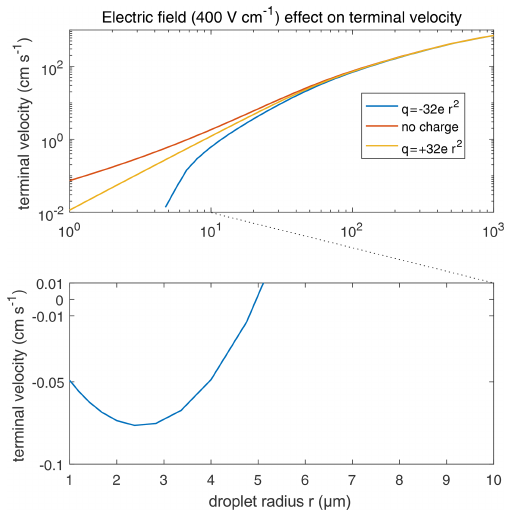
Figure 16. Terminal velocities of droplets in an external electric field 400Vcm − 1 . Different lines denote different droplet charge conditions. It is significant that the terminal velocity of negatively charged droplets smaller than 5µm turn upwards, leading to the dis- continuity of the lower curve in the